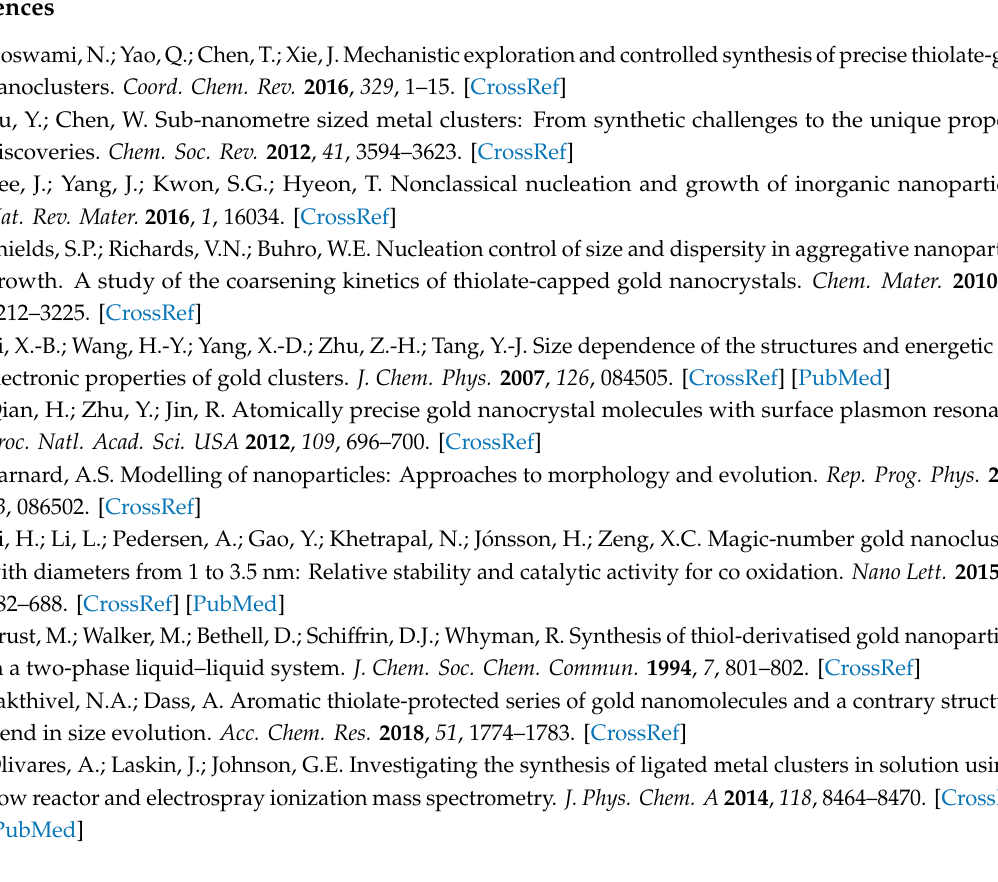
Figure S8: Analysis of a band forming experiment, where gold clusters where formed, with ULTRASCAN. Shown are the fits for the sedimentation coe ffi cient and v for representative wavelengths of experiment A-3, Figure S9: Individual UV / Vis spectra extracted from the PCSA MWL analysis for each species. For better overview they were separated in two di ff erent graphs, Figure S10: 3D plot of the multiwavelength analysis of experiment A-1 of a band forming experiment of gold clusters. The species are plotted versus the wavelength, Figure S11: 3D plot of the multiwavelength analysis of exp C of a band forming experiment of gold clusters. The species are plotted versus the wavelength; 4. Overview of the species from analysis, Table S1: Overview of all the species found in analysis of band forming experiments of gold clusters in AUC. Shown are all the species found for SEDFIT analysis at 510 nm of each experiment and the species found in MWL analysis in ULTRASCAN of exp A-1, A-3 and C; 5. Thioglycerol, Figure S12: A 3D model of thioglycerol drawn with MATERIALS STUDIO; 6. Core-shell model for size evaluation, Video S1: Video of the AUC raw data of a band forming experiment for the in-situ nucleation of gold clusters obtained from the multiwavelength AUC over the time of the